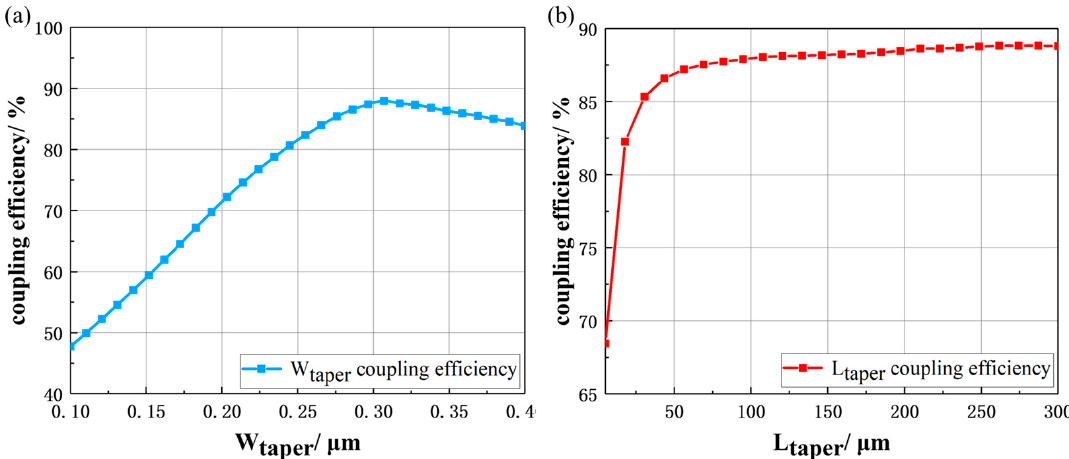
Figure 5. The simulation curve of the coupling e ffi ciency at di ff erent widths ( a ) W taper and ( b ) L taper .